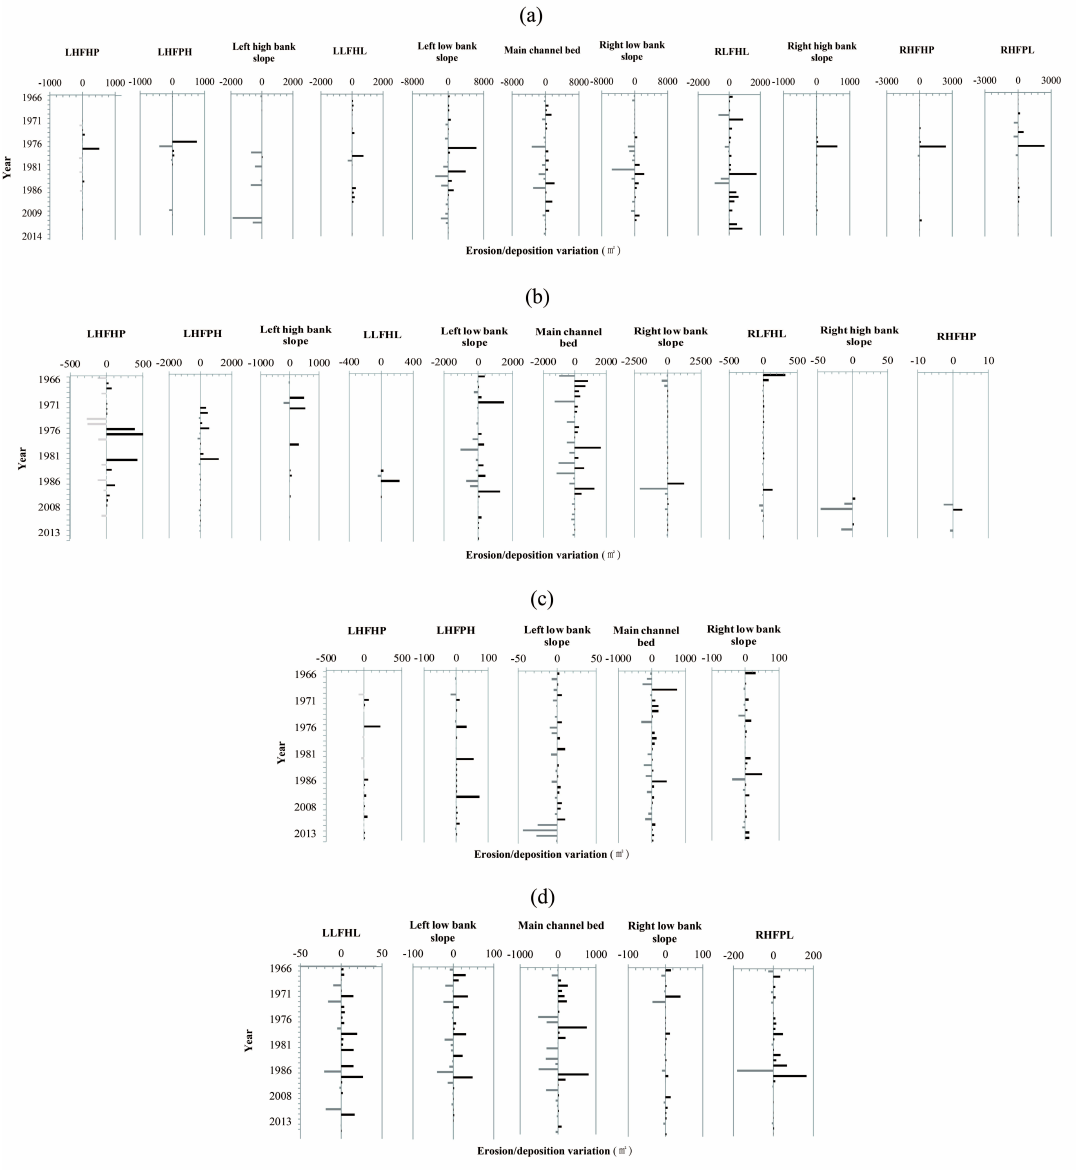
Figure 6. Changes in erosion and deposition of different geomorphic units in Jiahetan( a ), Gaocun ( b ), Luokou ( c ) and Lijin ( d ) sections of the lower Yellow